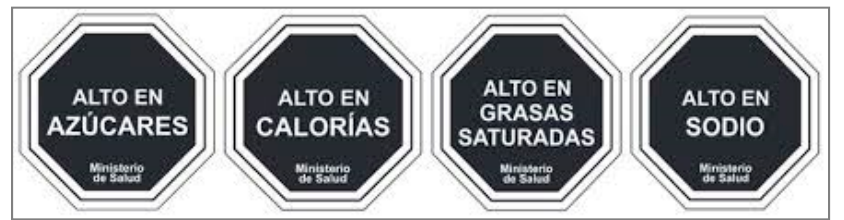
Figure A11. Warning Signs (Chile, Uruguay, Peru) identifies foods high in energy, sugar, sodium, saturated fat or potentially other nutrients that should be consumed less. The reference base is 100 g or 100 mL, or portion depending on the country. Directiveness: Diet-Directive; Scope: Warned food; Gradation: Binary; Set of Reference: Across-Category; Sign: Words, Ideograms.